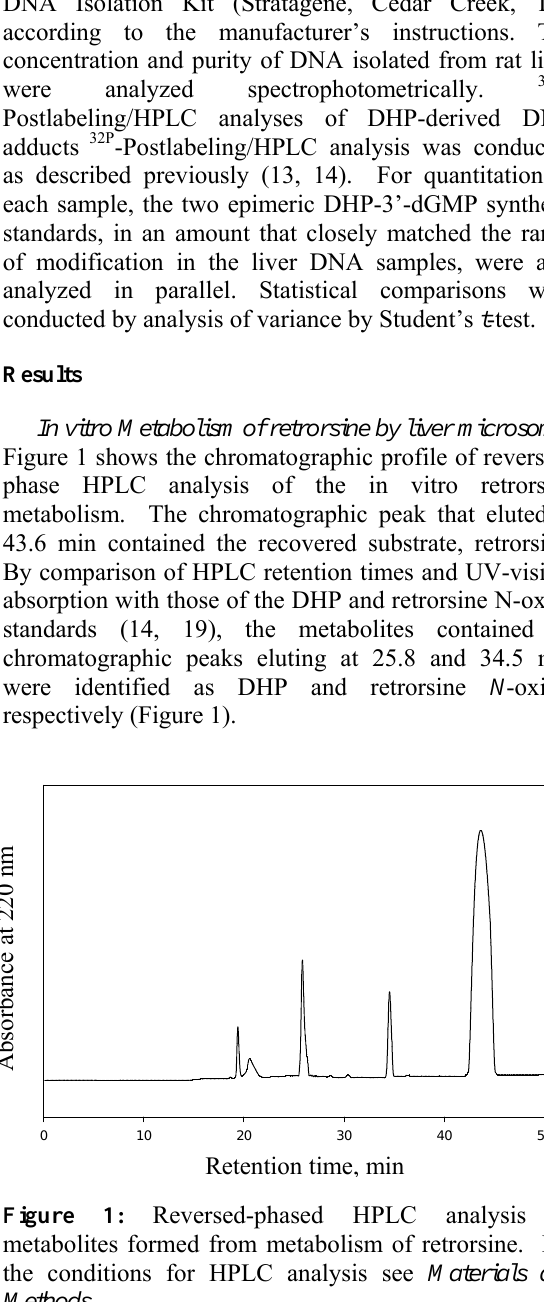
1: Reversed-phased HPLC analysis of